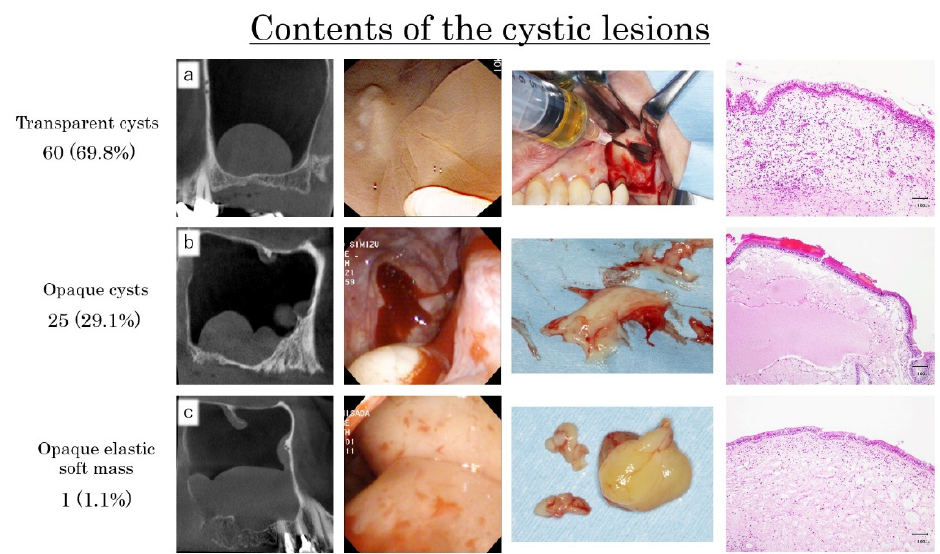
Figure 11. ( a ): 68 years old female. The content of a yellowish transparent cystic lesion was serous fluid and could be aspirated smoothly with a fine 18-gauge needle. ( b ): 48 years old male. The content of a white opaque cystic lesion was milky-white viscous, and it was difficult to be aspirated. ( c ): 30 years old female. The content of a white opaque cystic lesion was organized and exhibited elastic soft mass as with a tumor. All of the histological specimens were diagnosed as APs with moderate infiltration of inflammatory cells.